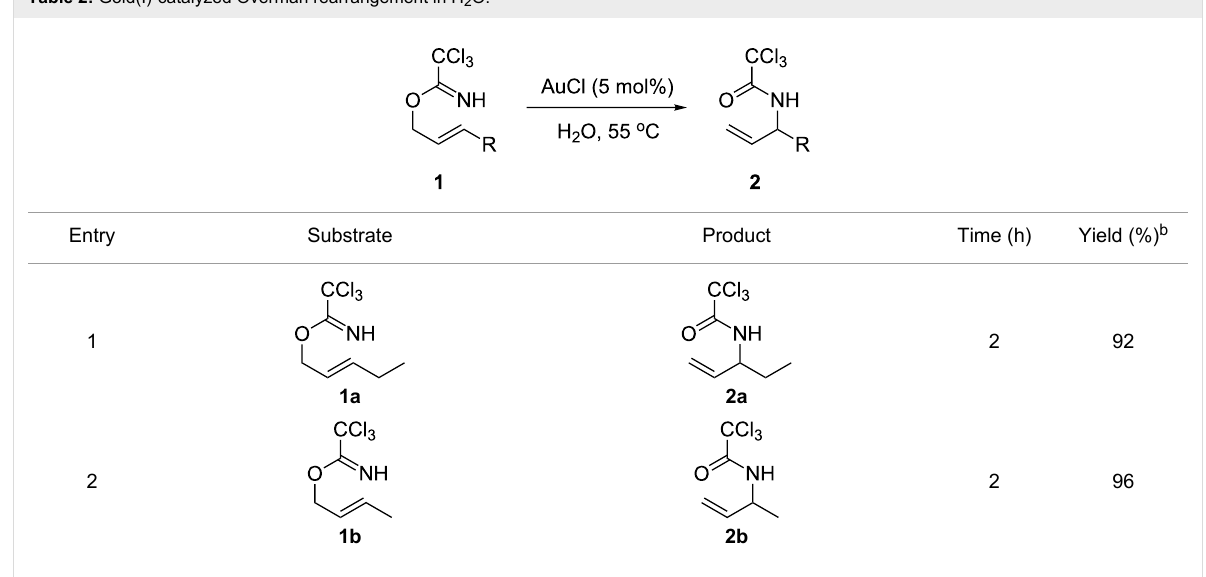
Table 2: Gold(I)-catalyzed Overman rearrangement in H 2 O. a